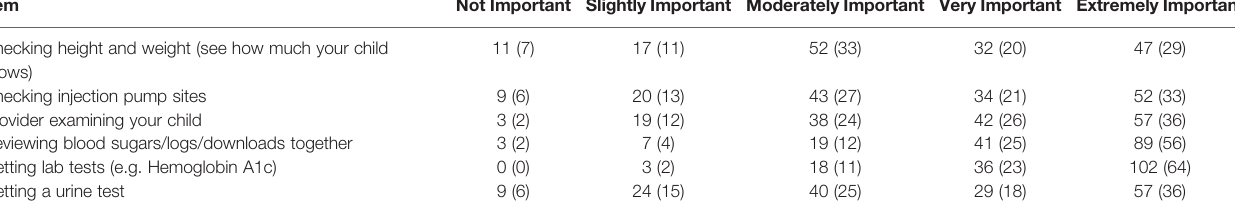
TABLE 3 | Parent-rated importance of different aspects of in-person diabetes visits.